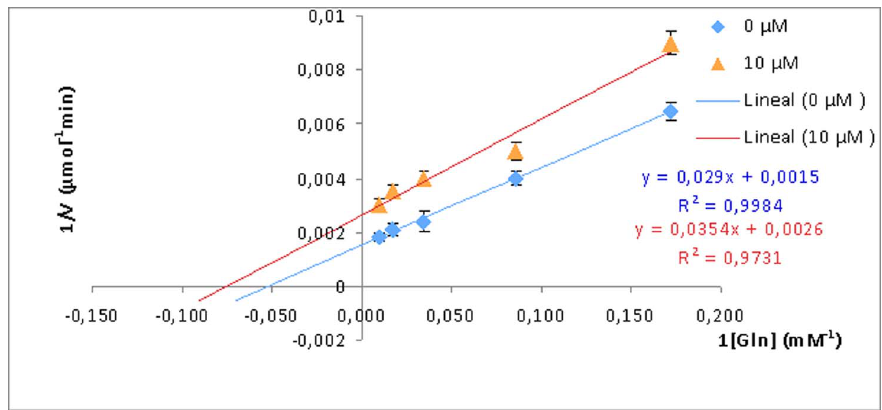
Figure 3. THDP17 inhibition kinetics. A lineal double reciprocal plot (1/v against 1/[Gln]) in absence (0) and presence (10 m M) of the inhibitor is shown. V max and K M values for PAG were 0.67 mmol min 2 1 , and 19.33 mM, respectively. In the presence of THDP-17 both parameters were modified: V max-ap =0.38 mmol min 2 1 , and K M-ap =13.62 mM, indicating an uncompetitive inhibition. All experiments were performed in triplicates; p .